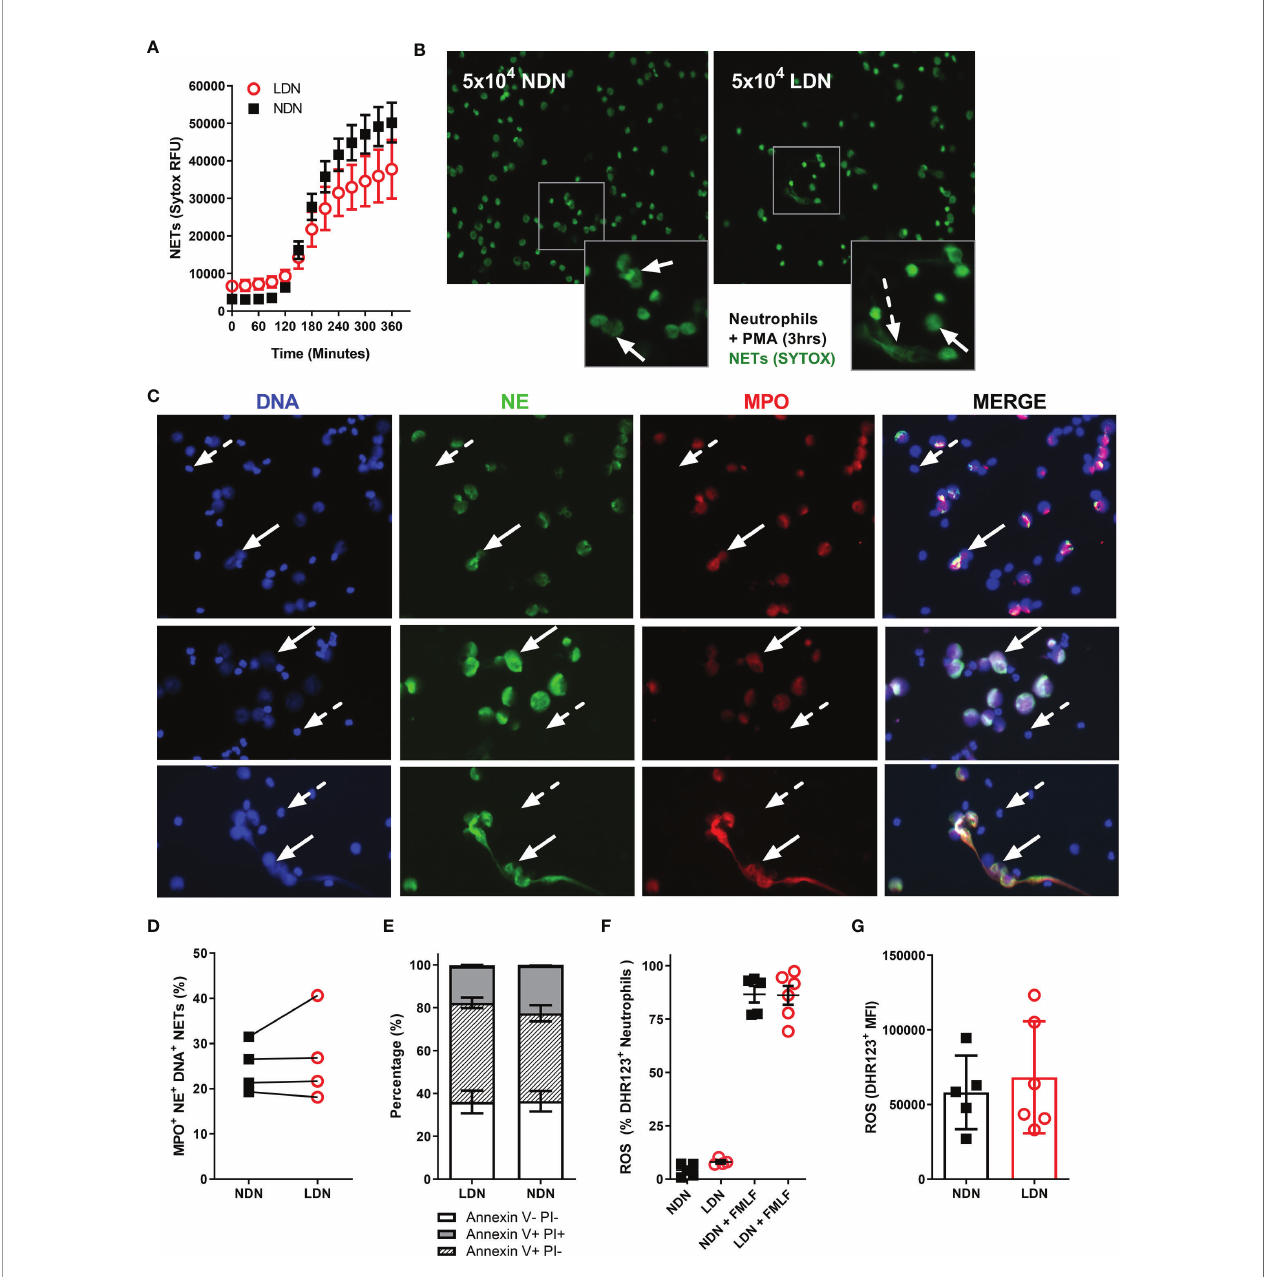
FIGURE 3 | LDNs form fewer NETs than NDNs in healthy individuals. (A) NET formation by 5x10 4 LDNs or NDNs, stimulated with PMA measured by SYTOX green fl uorescence over 6 hours (N=4-6). (B) Representative images of NETs formed by LDNs and NDNs after 3 hour stimulation with PMA. Solid arrows show ‘ cloud-like ’ NETs and dashed arrows show ‘ stretched ’ NETs. (C) Representative NET formation, stained with Hoecsht for DNA (blue) and myeloperoxidase (red) and neutrophil elastase (green) antibodies 4 hours post PMA stimulation. Solid arrows show NETing neutrophils, dashed arrow shows non-NETing neutrophils. All images are from a single donor. (D) Quanti fi cation of DNA+ MPO+ NE+ NETs in culture after 4 hours stimulation with PMA, presented as percentage of total neutrophils (N=4). (E) Apoptotic neutrophils measured by Annexin V and PI expression after 20 hours in culture (N=4-5) (F) Percentage of LDNs and NDNs positive for ROS before and after FMLF stimulation, measured by DHR123+ fl uorescence. (N=5-6) (G) ROS generated by LDNs and NDNs in response to FMLF stimulation, expressed as DHR123 mean fl uorescence intensity